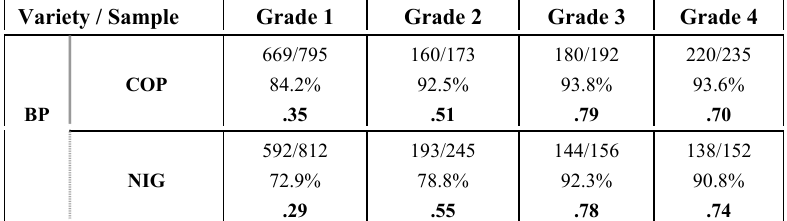
Table XXI: Third person plural verbal